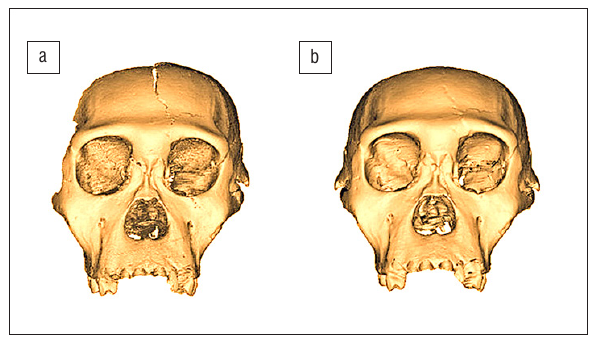
MH1 cranium (a) before and (b) after